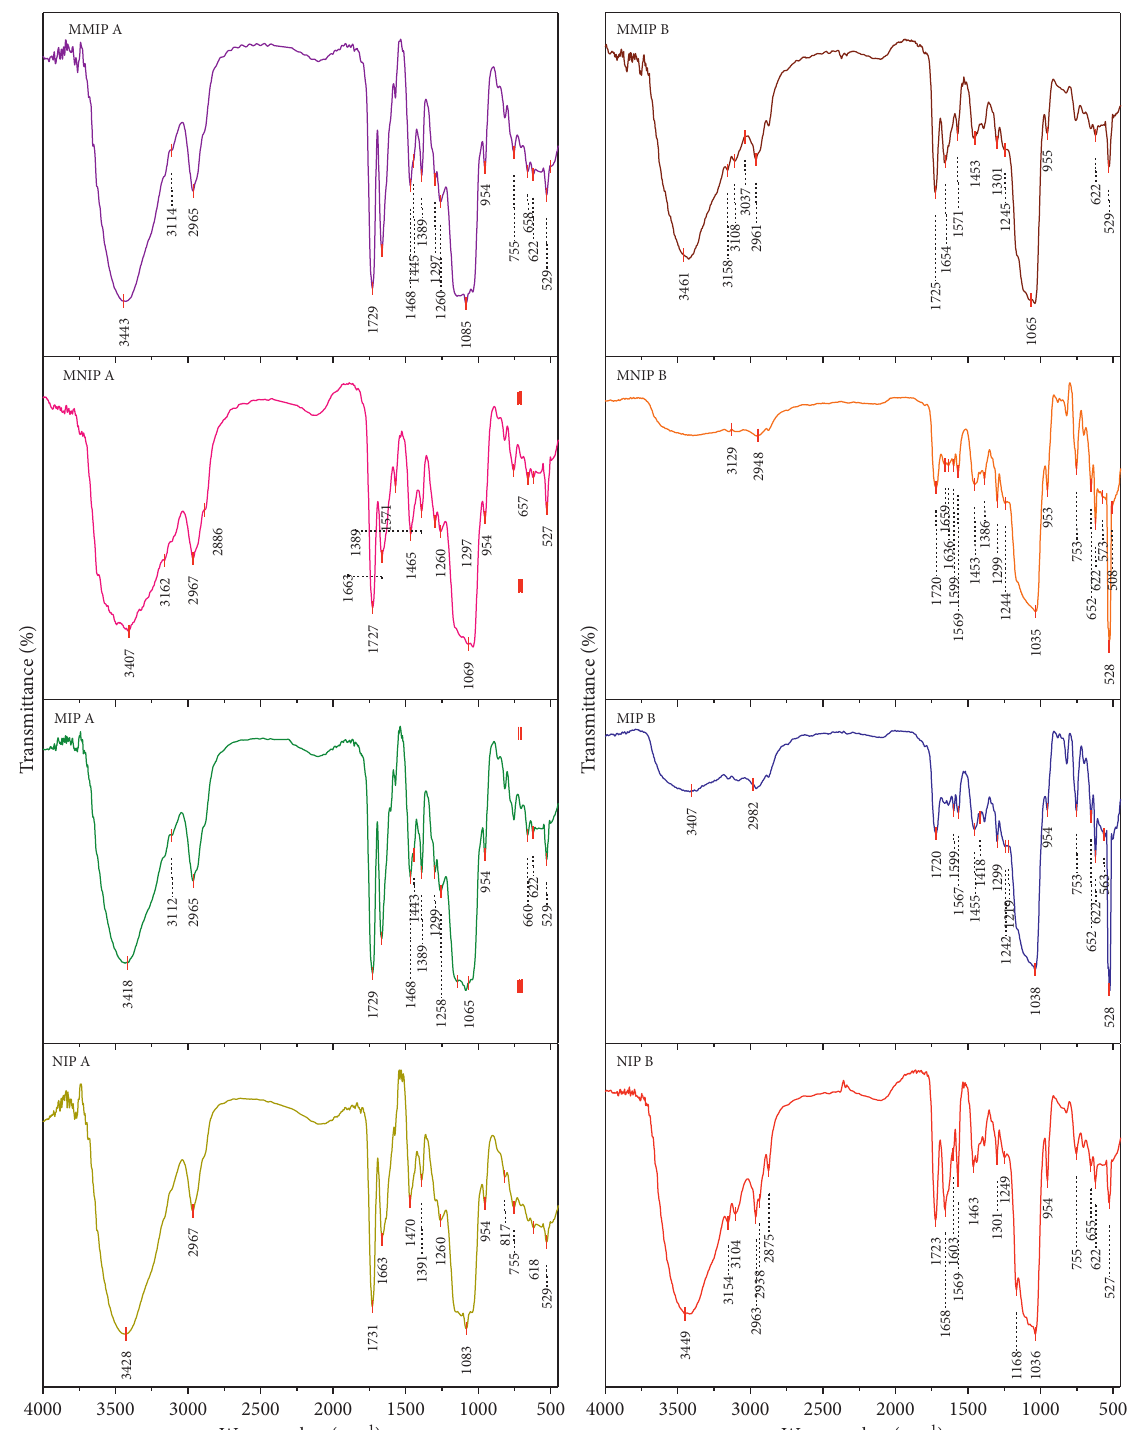
Figure 3: FTIR spectra of MMIP, MNIP, MIP, and NIP monoliths. The A and B notations correspond to the monoliths with the crosslinker of TRIM and EDMA, respectively (see Table